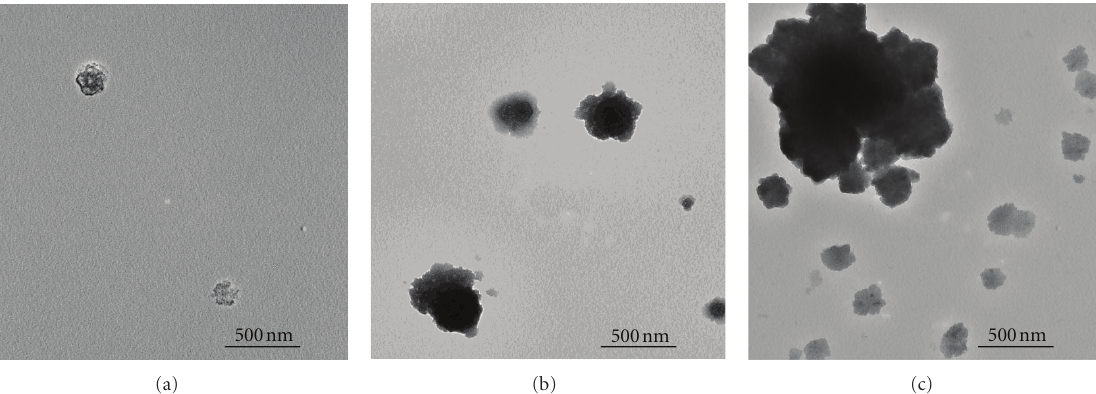
Figure 8: TEM images of copper particles at di ff erent copper ion concentrations (a): 0.3 × 10 − 3 , (b): 0.6 × 10 − 3 , (c): 3.0 × 10 − 3 mol of Cu ions).